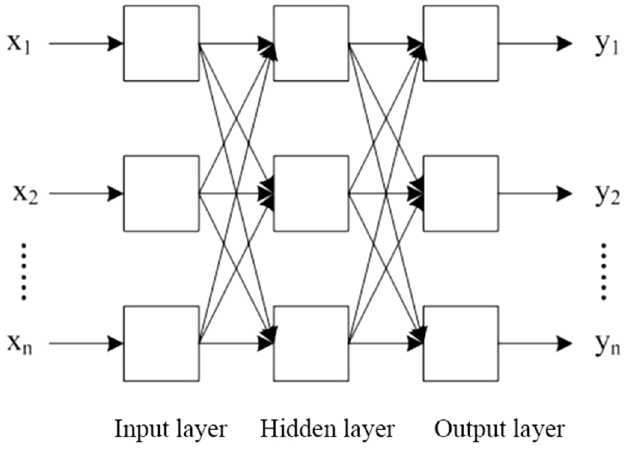
Fig. 4. BPNN structure.